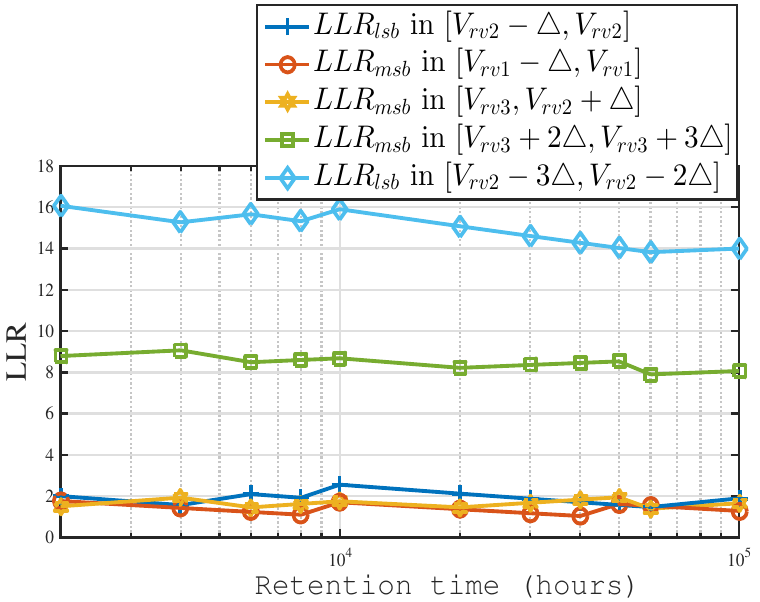
Figure 4. Plot of the relative log-likelihood ratio (LLR) versus data retention time at PE = 1 K , (cid:52) = 0.05 and s =